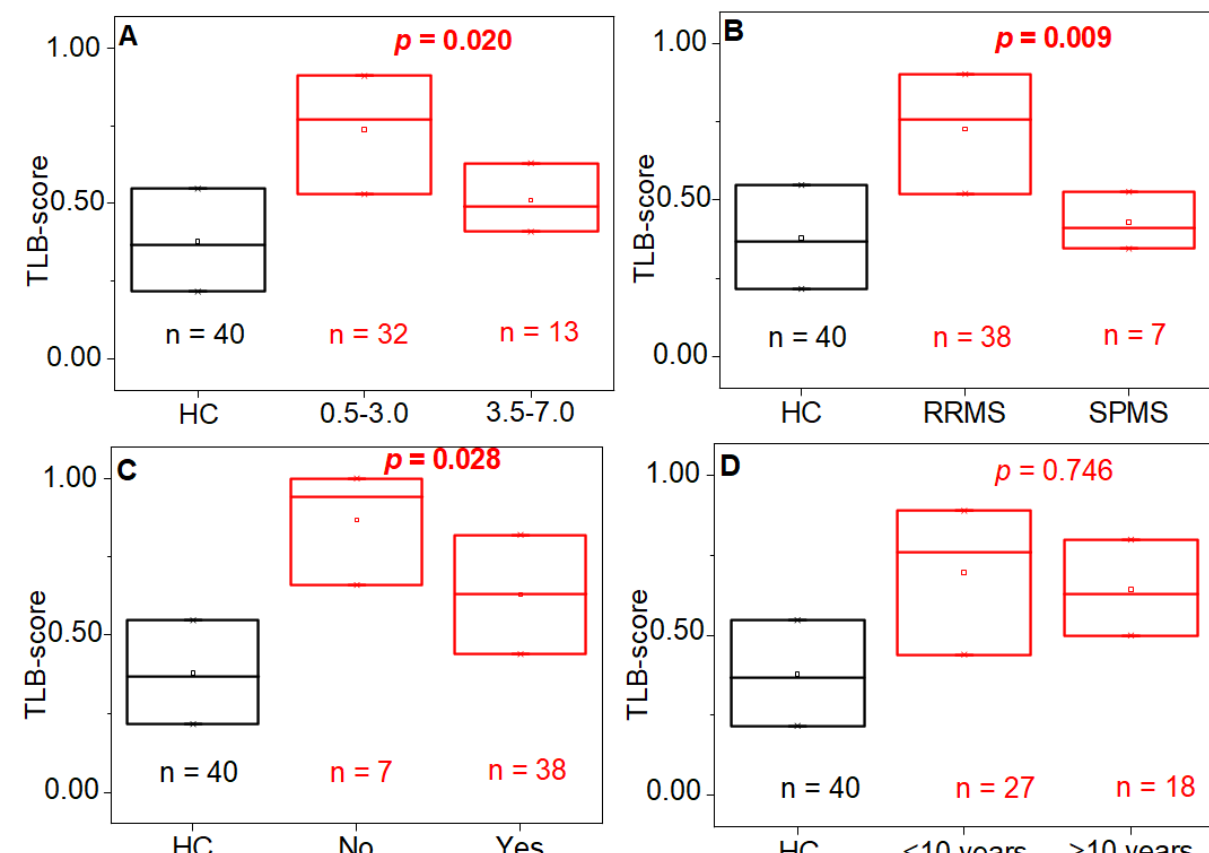
Figure 8. Distribution of the probability score (TLB score) for healthy individuals (HC group, black) and multiple sclerosis patients (MS group, red) according to ( A ) level of disability (EDSS = 0.5–3.0: mild disability; EDSS = 3.5–7.0: moderate/severe disability), ( B ) diagnosis stage (RRMS: early stage; SPMS: advanced stage), ( C ) pharmacological treatment (no/yes), and ( D ) disease duration (more or less than 10 years). The p -value (Wilcoxon test) indicates there is a statistically significant difference regarding the level of disability, the diagnosis stage and the therapy in the MS group ( p -value < 0.05) but not in the disease duration ( p -value > 0.05).